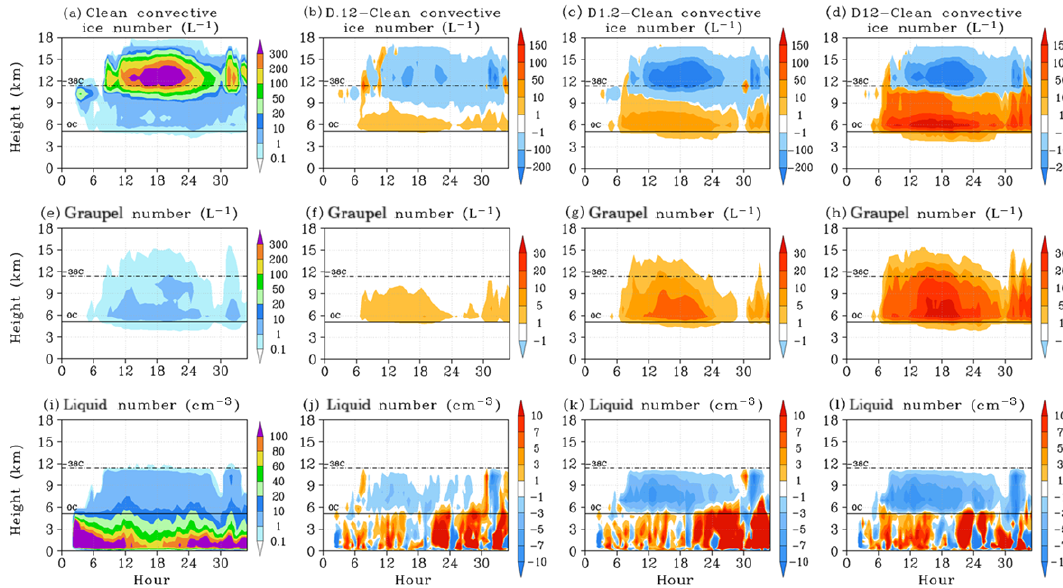
Figure 6. Convective-cloud-averaged profiles (height vs. time) and dust case minus Clean case difference plots of ice number concentration (a–d) , graupel number concentration (e–h) , and liquid number concentration (i–l) . Columns: Clean (a, e, i) , D.12 – Clean (b, f, j) , D1.2 – Clean (c, g, k) , and D12 – Clean (d, h, l)